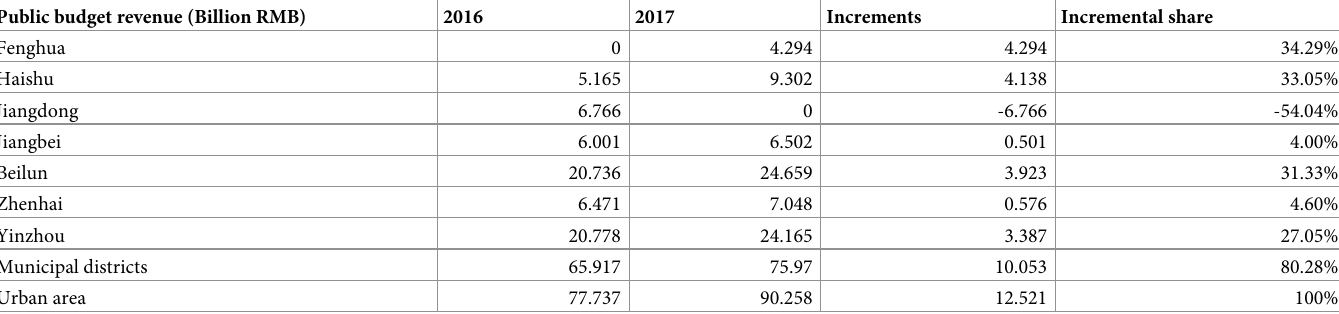
Table 8. Comparison of public budget revenue of Ningbo Municipality, 2016 and 2017.